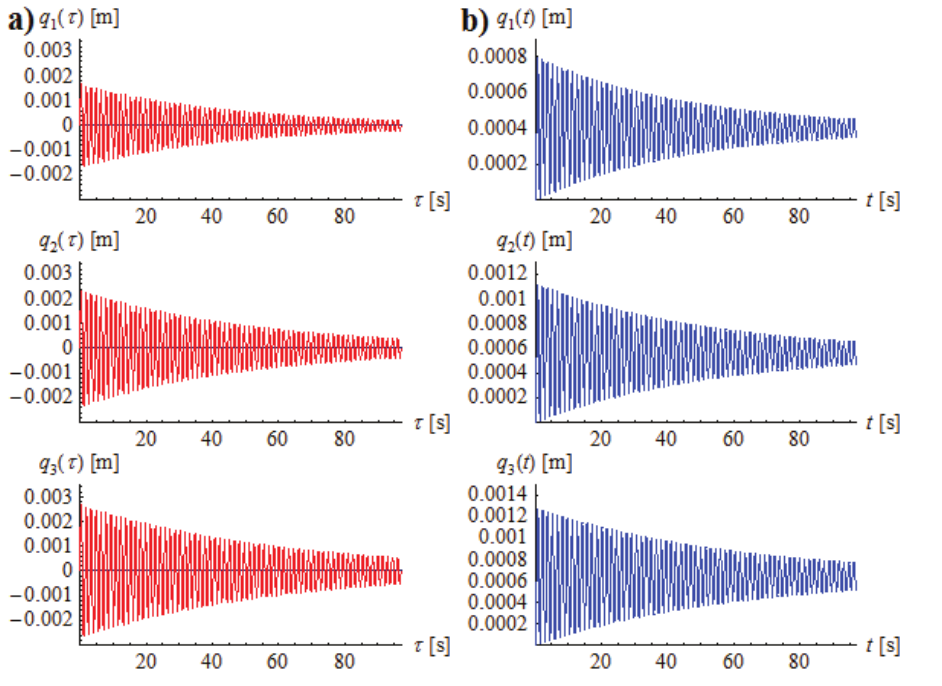
Figure 9 : The results obtained from the fifth measurement: (a) displacement plots in the time domain t and (b) displacements determined in accordance with formula